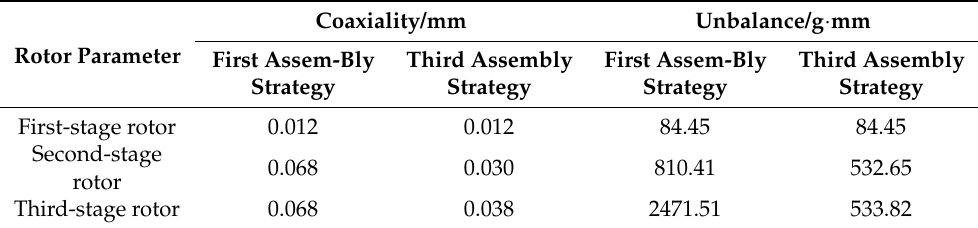
Table 4. Coaxiality and unbalance under different assembly strategy.